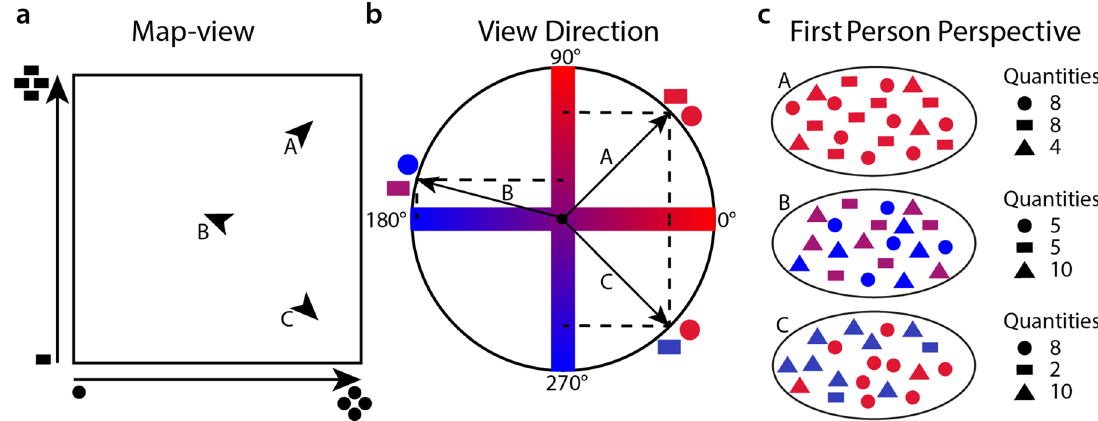
Figure 1. Quantity space. ( a ) Map-view of the two-dimensional space. The X-dimension is the quantity of circles, and the Y-dimension the quantity of rectangles presented to the participant. When a participant moves forward, the quantities of the items change. Arrows A, B and C represent example positions, with the arrow direction showing view direction. ( b ) We used colour to encode view direction. The colour-code ran between blue and red, with blue indicating a decrease, red indicating an increase and purple indicating no change in quantity if a participant were to move forward. For the X-dimension (circles) the cosine of the view direction determined the colour, and for the Y-dimension, the sine of the view direction determined the colour. While turning, the colours are continuously updated while the quantities stay stable. Colour code for the view directions of positions A, B and C from ( a ) are shown as examples. ( c ) Down-sampled (5 %) representation of the first-person perspective when standing at the locations A, B and C, as presented in ( a , b ). The participants only saw the space from a first-person perspective, and had to navigate using the quantities of items for positional information and colours for directional information. The triangles are filler items, so that each position always contained 400 items (in this example 20 items). Thus, visual complexity for the different positions was kept more stable. Triangles are dimension-specific: they share the colour of the dimension they are “filling-up”. Numbers indicate the quantities of the